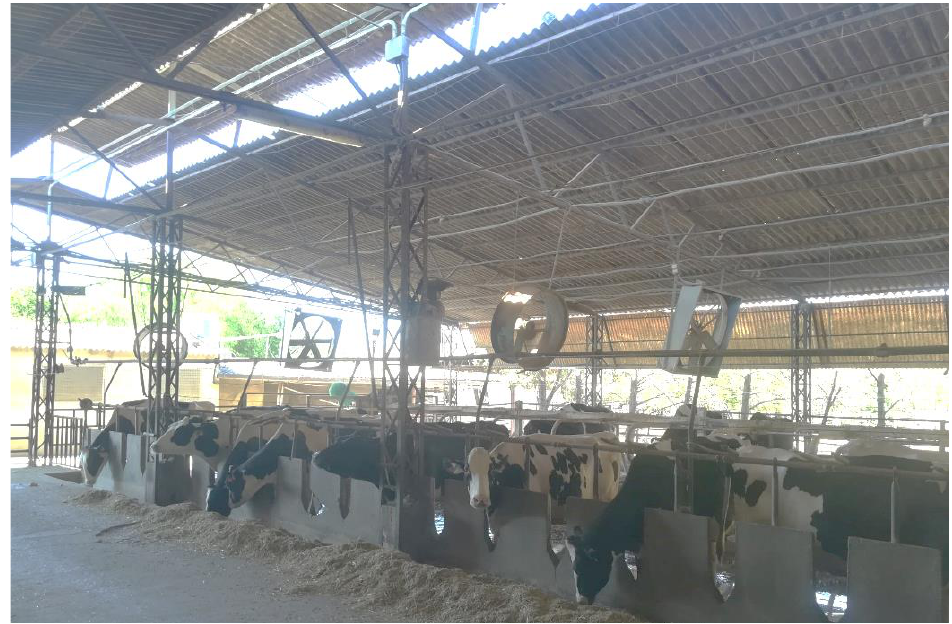
Figure 1. Indoor view of the barn characterized by completely open sides.